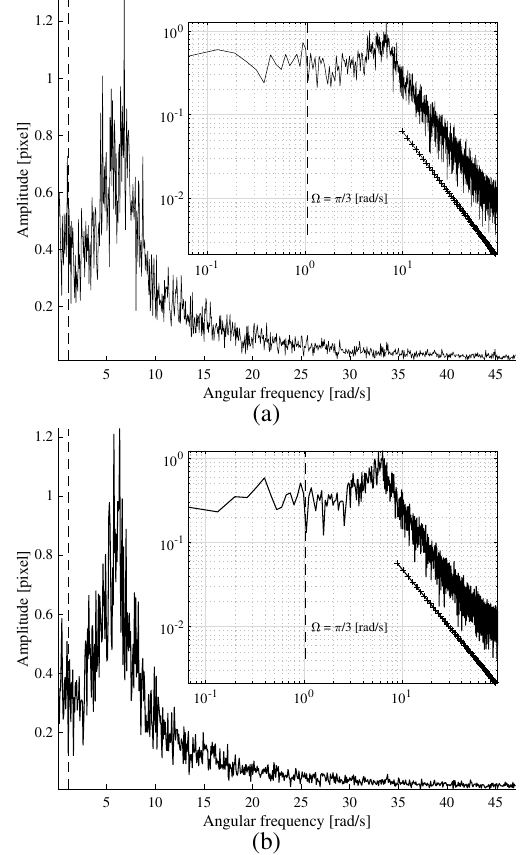
Figure 5. Influence of drum size: (a) The SSA spectrum for polyhedral particles in the small drum with ⌦ = ⇡ / 3 [rad / s]; The shifted fitting line (’ + ’ marker) for the decay has a slope about a = 1 . 5. (b) The SSA spectrum for polyhedral particles in the large drum with ⌦ = ⇡ / 3 [rad / s]; The shifted fitting line (’ + ’ marker) for the decay has a slope about a = 1 . 4. The vertical dashed line indicates the rotation speed of the